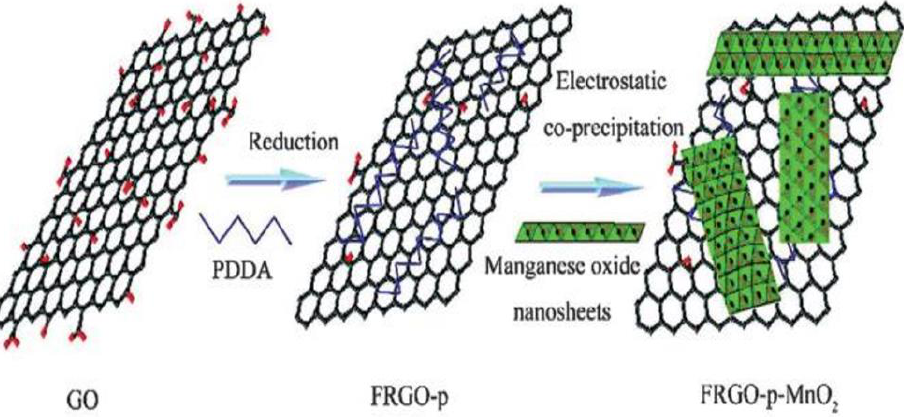
Figure 11. Schematic representation of the assembly process of FRGO-p-MnO 2 . Copyright © 2015 Elsevier Ltd. SMNs were fixed on the surface of rGO self-assembly and the resulting nanocomposites (SMN-RGO) could be used in supercapacitors. As shown in Figure 12a, the rectangular area of the cyclic voltammetry (CV) circuit in SmRGO2 (the theoretical mass ratio Sm 2 O 3 /GO is 1/1) was the largest. The specific capacitance (SC) value of the electrode calculated at a scanning rate of 50 mv/s was 227 F/g, which may have been caused by the synergistic effect between the components. Furthermore, the number of available active sites and the energy that could be stored at the supercapacitor electrode increased [100]. As shown in Figure 12b, the SCs of rGO, Sm 2 O 3 , SmRGO1 (the theoretical mass ratio Sm 2 O 3 /GO is 2/1), SmRGO2, and SmRGO3 (the theoretical mass ratio Sm 2 O 3 /GO is 1/2) decreased by varying degrees after 4000 cycles. The SC of SmRGO2 showed very high cycle stability, decreasing by 1.0% after 4000 cycles. Therefore, the application of the rGO dosage is very important to improve the cycle stability [100].